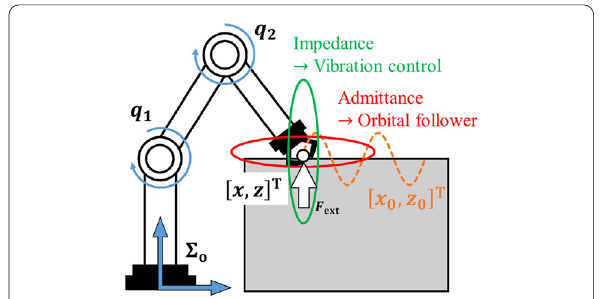
Fig. 11 Control object (two‑dimensional